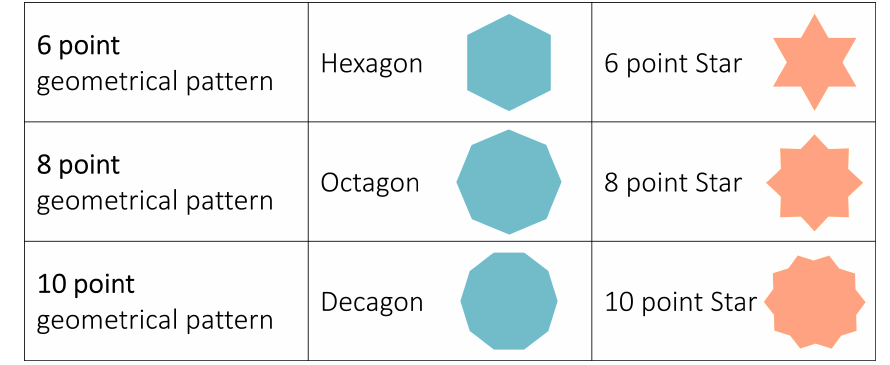
Figure 5. A few types of Islamic geometric patterns.